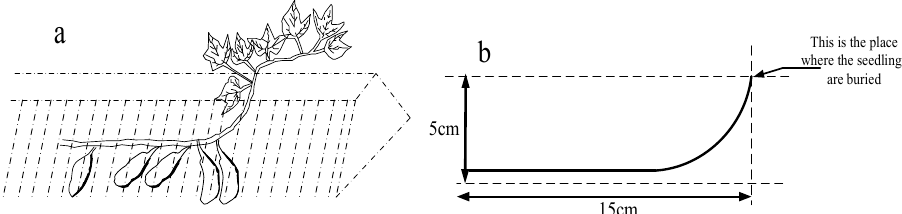
Figure 9. Horizontal transplanting method. ( a ) Transplanting trajectory schematic diagram ( b ) Mathematical description of the trajectory.